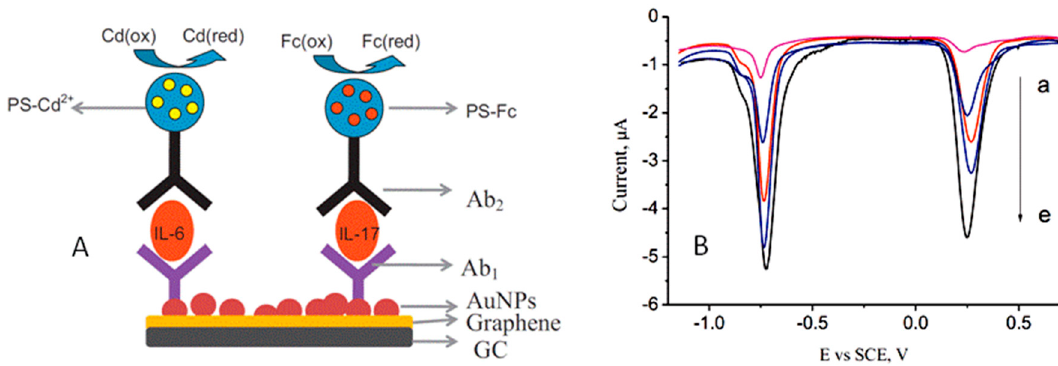
Figure 11. ( A ) Scheme of the electrochemical immunosensor constructed for the simultaneous determination of IL-6 and IL-17 using two different tags to polystyrene spheres and Cd 2+ and Fc as the electroactive labels. ( B ) SW voltammograms recorded for the simultaneous detection of (a–e) 5, 50, 100, 500 and 1000 pg·mL − 1 IL-6 (left) and IL-17 (right). Repinted from Ref. [53] with permission.